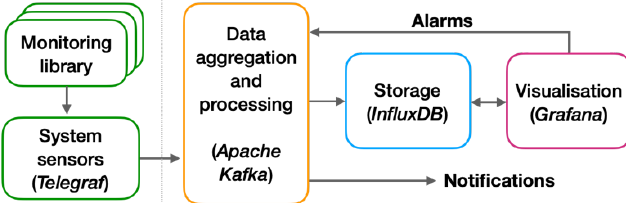
Fig. 1. Monitoring subsystem architecture and message